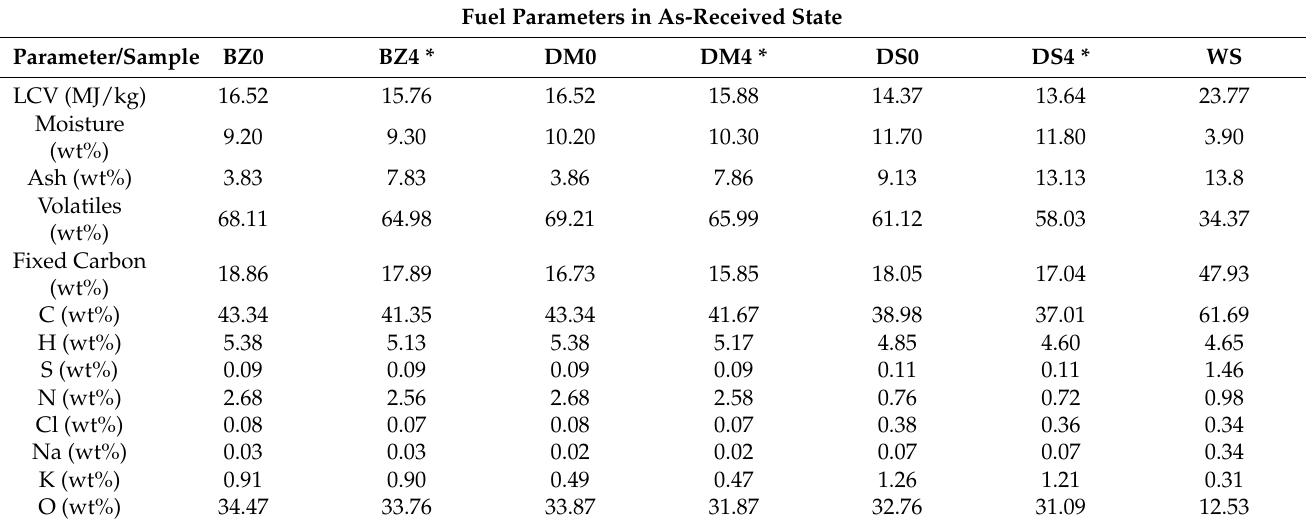
Table 2. Results of analysis of investigated fuels.